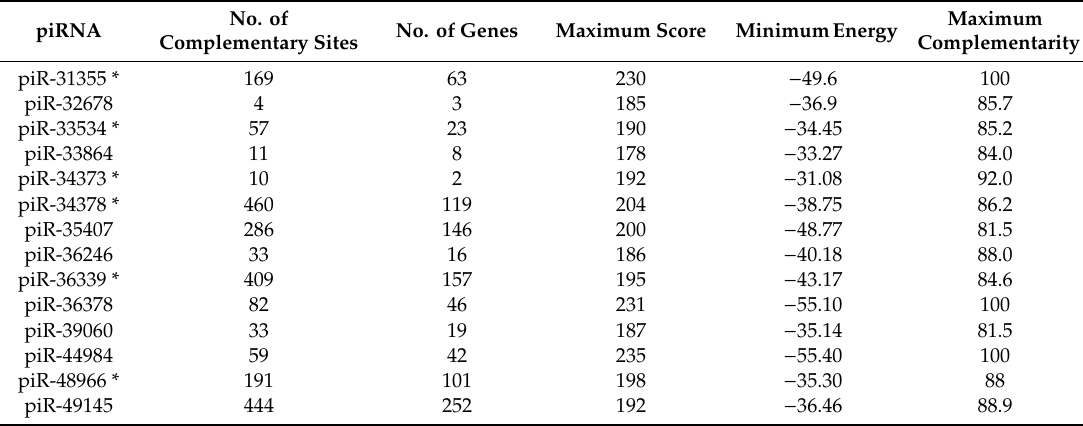
Table 3. Complementarity of DE piRNAs with mRNAs of human genes at the post-transcriptional level. piRNA